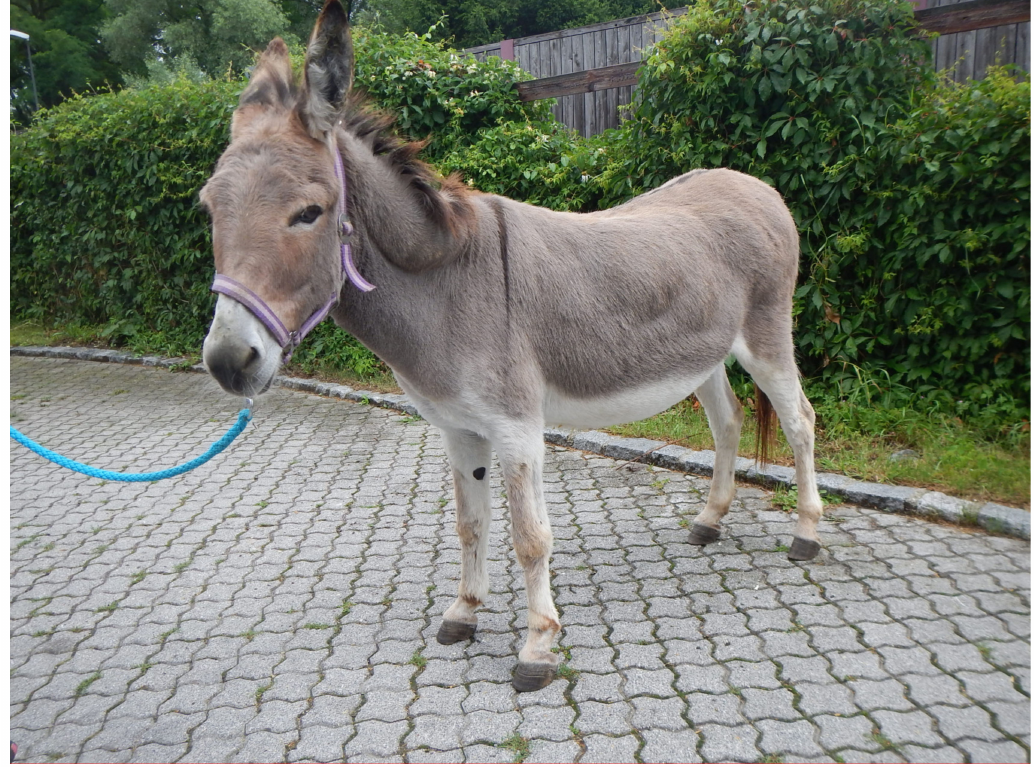
Figure 2. Obese donkey with a body condition score of